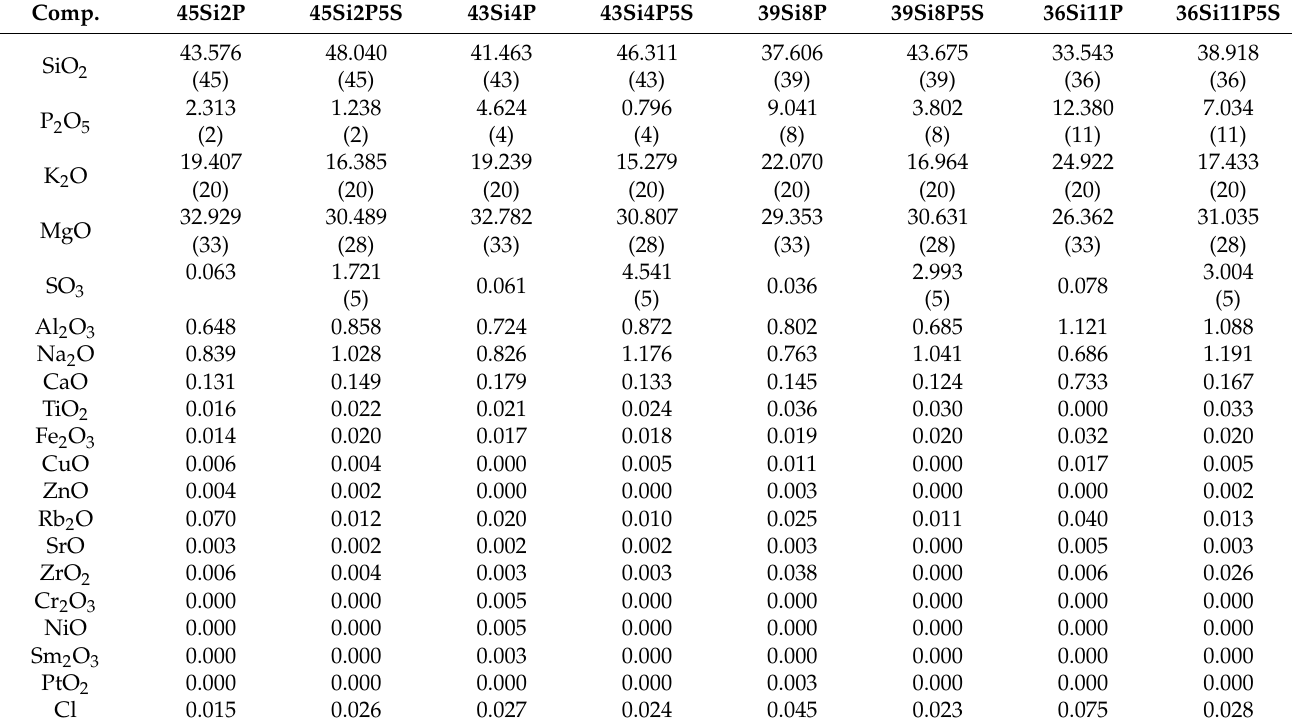
Table 1. Experimental glass chemical compositions from XRF analysis (nominal value in brackets) in mol.%.